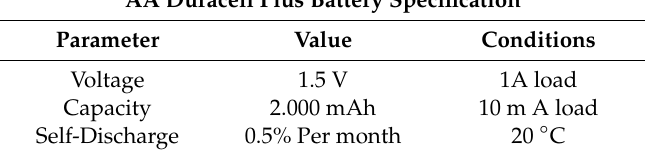
Table 1. Standard Battery characteristics with the appropriate condition associated with each parameter value.